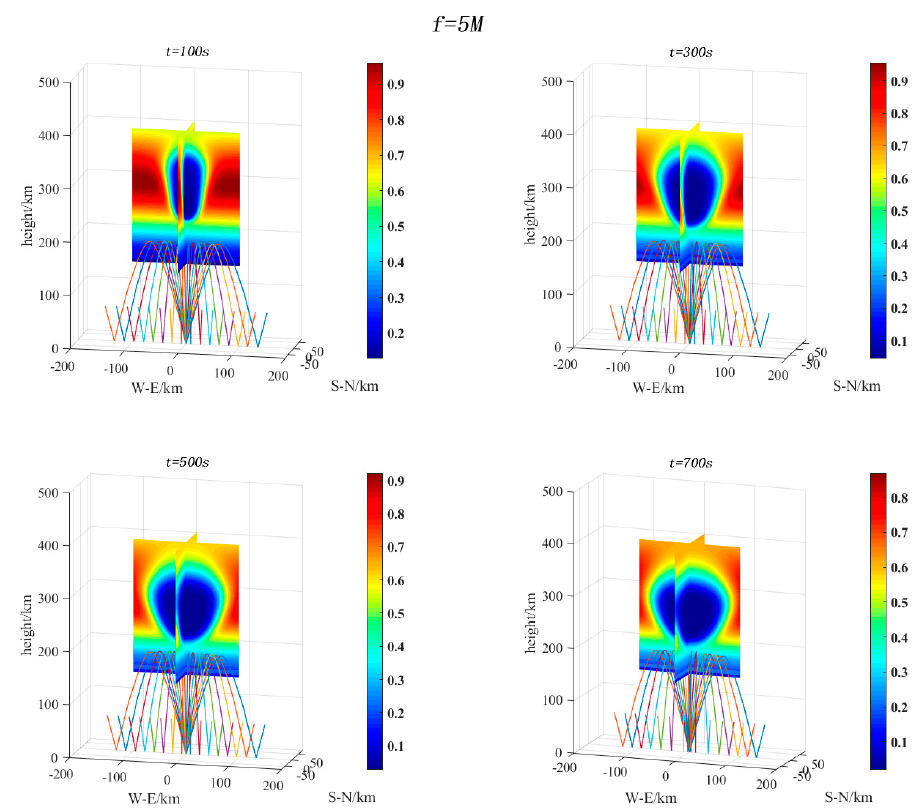
Figure 6. The 3D ray tracing simulation of 5 MHz shortwave echo path after CO 2 release of 100 s, 300 s, 500 s and 700 s (electron density unit: 10 6 cm − 3 ).